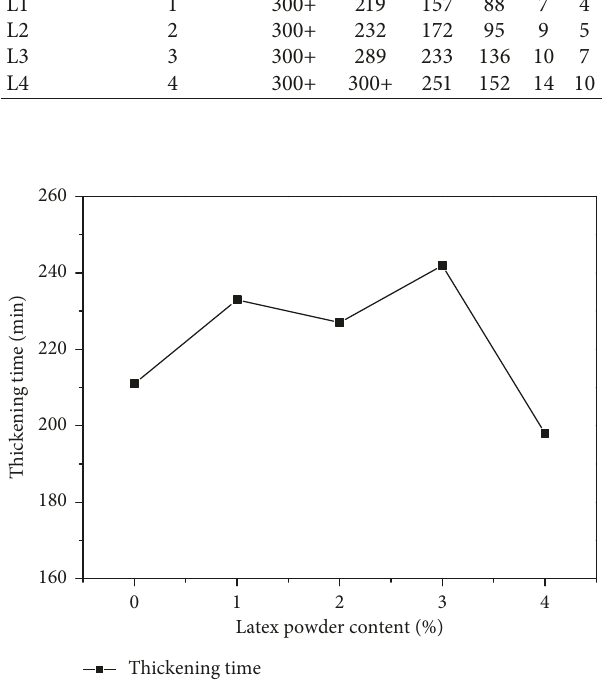
Figure 1: Dependence of latex powder content on thickening time of cement slurry.